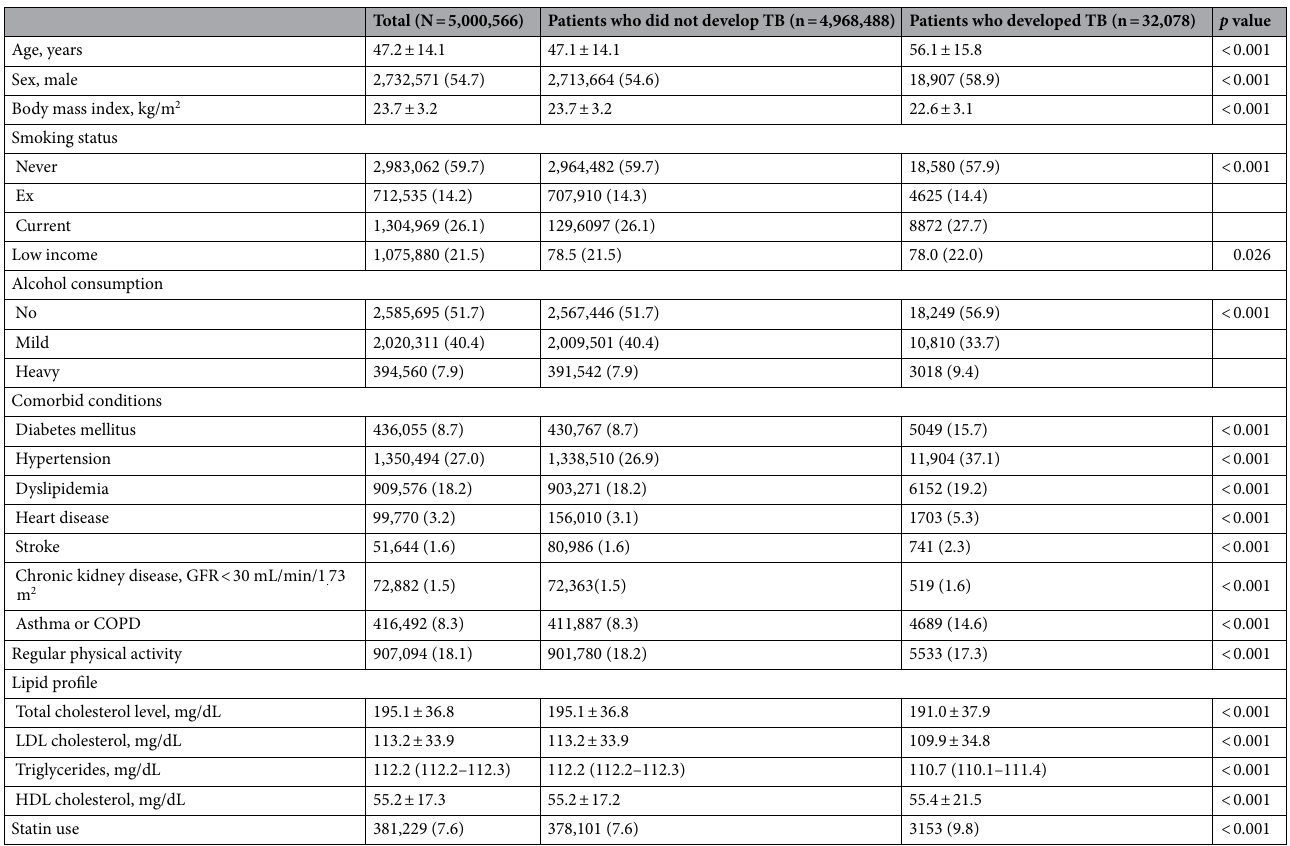
Table 1. Demographic data of subjects. Data are presented as mean ± standard deviation or median (interquartile range) for continuous variables and number (%) for categorical variables. TB tuberculosis,